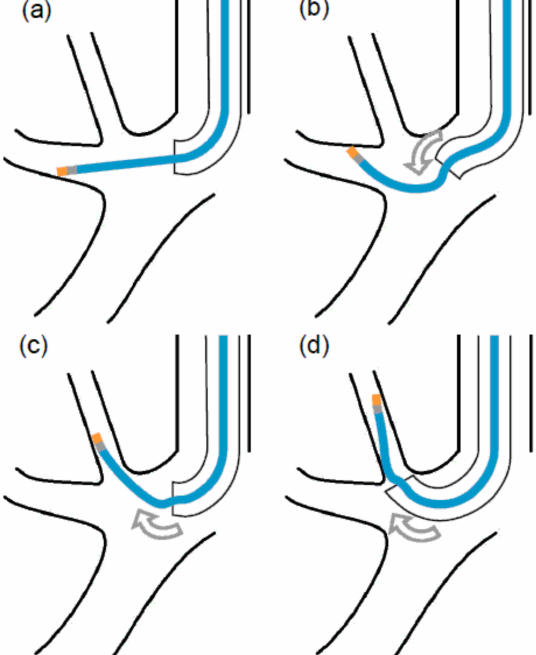
Figure 2. The cryoprobe bending method for peripheral pulmonary lesions. ( a ) When the cryoprobe has been bent as far as possible toward the lung apex, ( b ) the scope is bent in a down angle. ( c ) The shape memory property of the probe can be used to push it completely toward the lung apex. ( d ) Forward feeding of the cryoprobe instead of a guidewire, with simultaneous advancement of the scope, enables the confirmation of probe entry into the correct